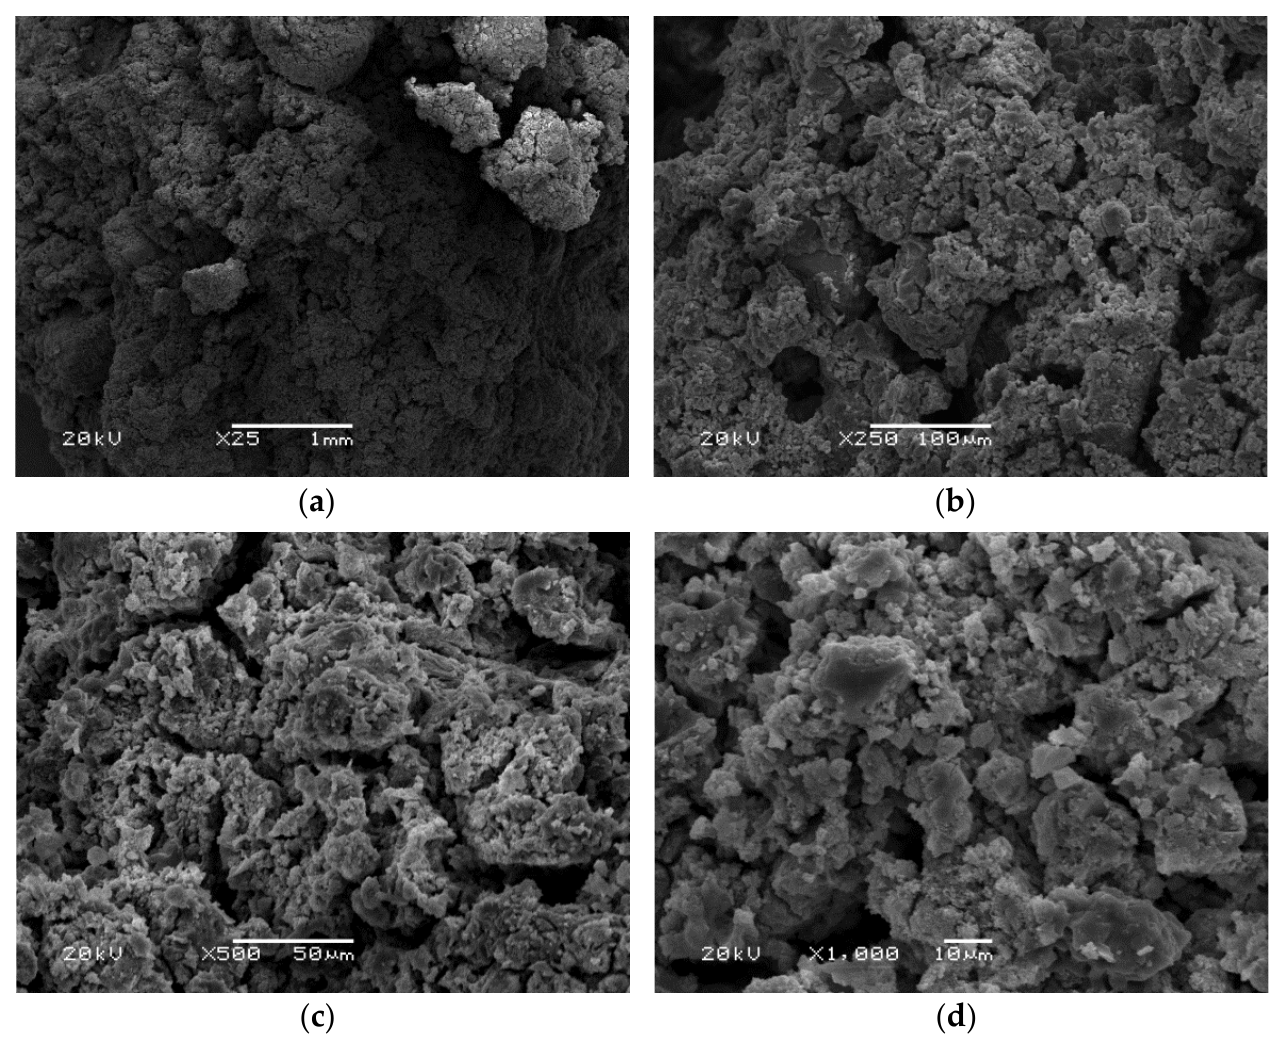
Figure 6. SEM pictures of materials based on waste incineration product in magnification: ( a ) 25×; ( b ) 250×; ( c ) 500×; ( d ) 1000×.